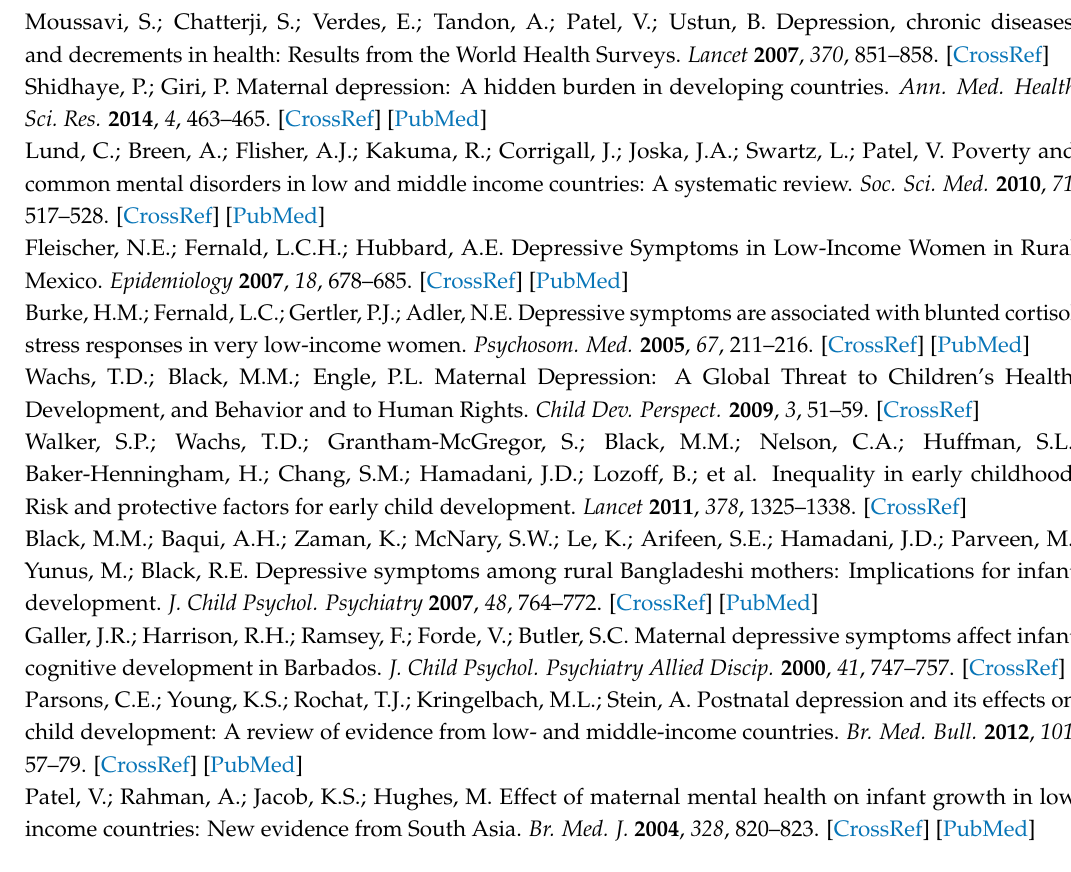
Table S1: Adapted Behavior Problems Index, Table S2: Center for Epidemiologic Studies—Depression (CES-D)